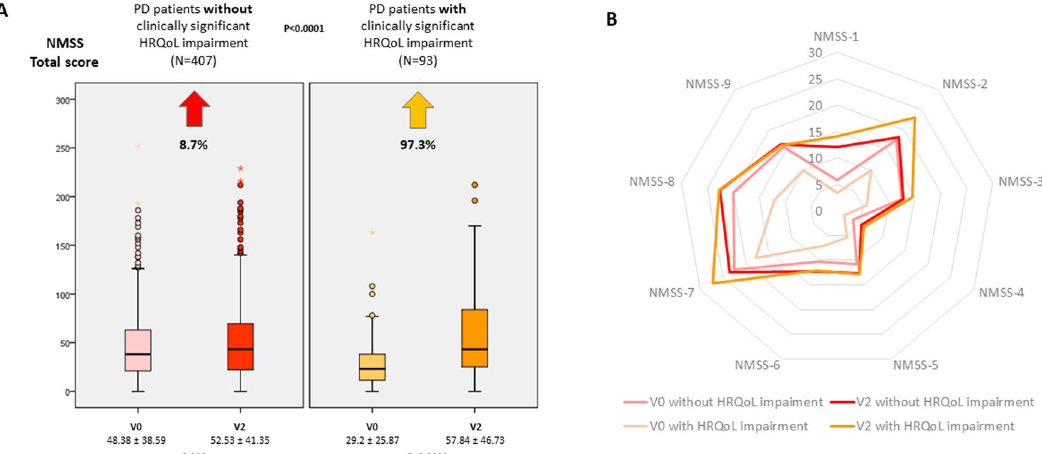
Fig. 2 Evolution of NMS after 2-year follow up. A Change in the NMSS total score from V0 (baseline) to V2 (2 year ± 1 month) in PD patients without vs with clinically signi fi cant HRQoL impairment. B Mean score on each domain of the ESS scale at V0 and V2 in PD patients without vs with clinically signi fi cant HRQoL impairment. Data are presented as box plots, with the box representing the median and the two middle quartiles (25 – 75%). p -values were computed using the Wilcoxon-signed rank test. Mild outliers (O) are data points that are more extreme